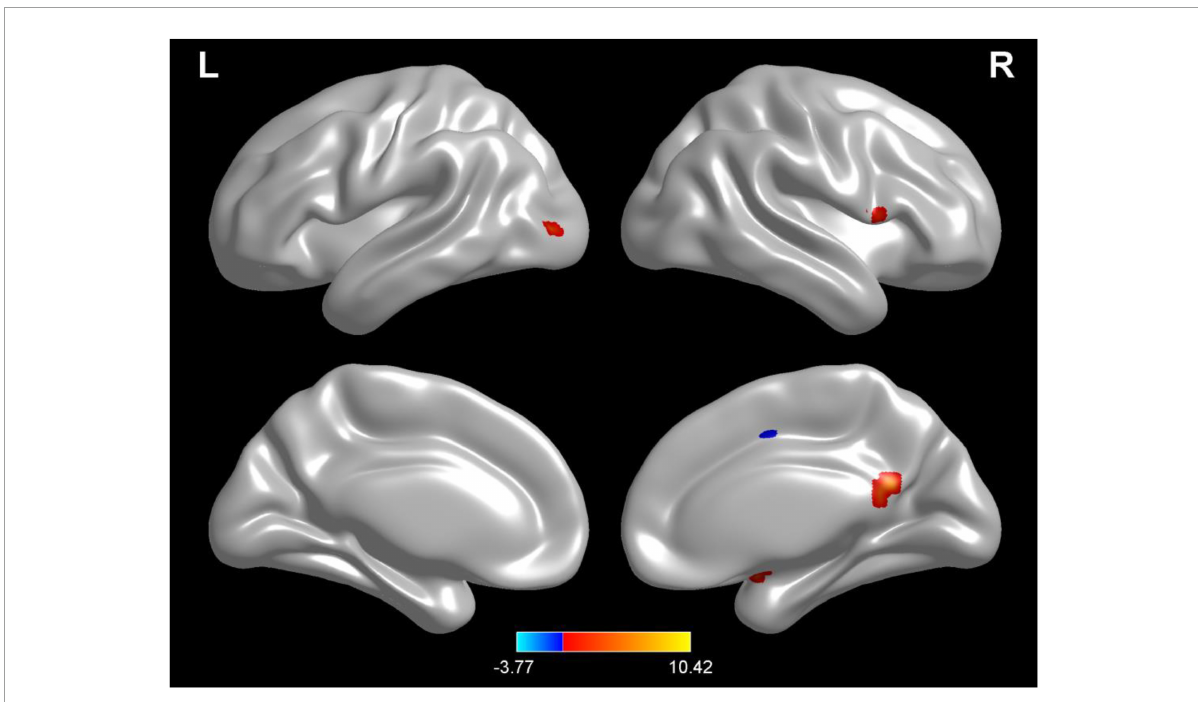
FIGURE6 Regional changes on the voxel-based three-dimensional displayed brain regional homogeneity (ReHo) among participants when compared with test 1 in baseline hydration state and test 2 in dehydration state. Warm colors mean that the ReHo value among participants in the baseline test was higher than that in the dehydration test; cold colors mean that the ReHo value among participants in the baseline test was lower than that in the dehydration test; p < 0.05 after false-discovery rate correction, voxel threshold of cluster > 10.